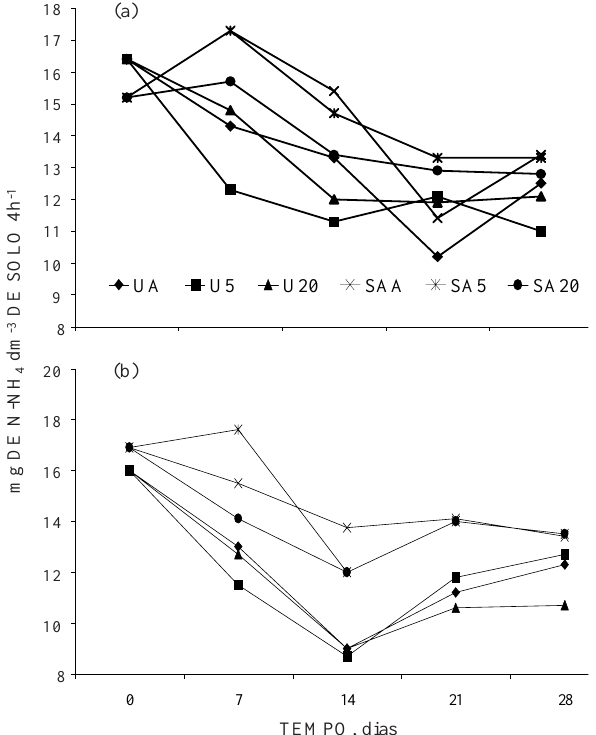
Figura 1. Efeito do tempo e condições de armazenamento sobre a velocidade de hidrólise dm -3 de solo 4 h -1 ), em da uréia (mg de N-HH 4 amostras de Latossolo Vermelho Aluminoférrico típico (a) e Latossolo Vermelho distrófico típico (b), em que: UA = úmida em temperatura ambiente; U5 = úmida a 5 o C; U20 = úmida a – 20 o C; SAA = seca ao ar em temperatura ambiente; SA5 = seca ao ar a 5 o C; SA20 = seca ao ar a -20 o